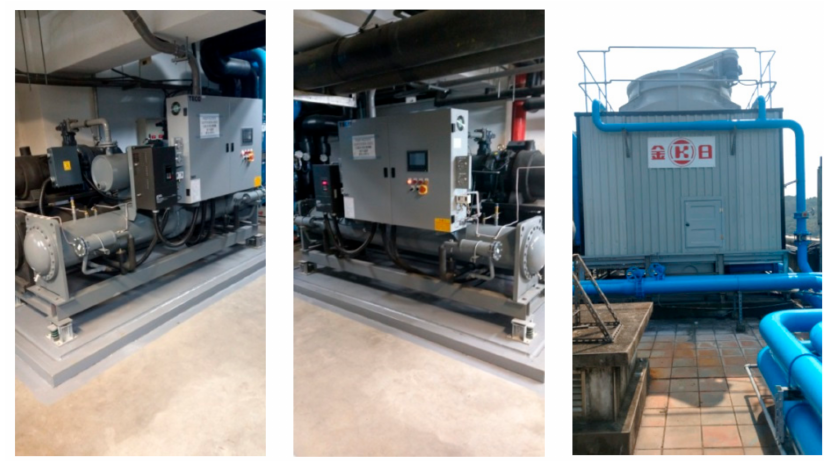
Figure 3. Replacement of IB air-conditioner and related equipment.